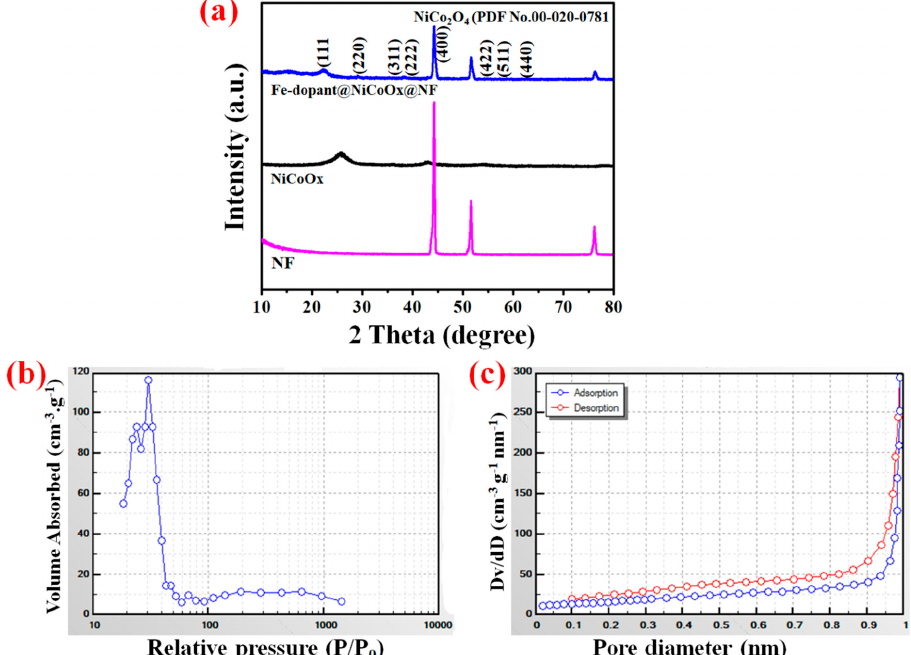
Figure 4. The NF, NiCoO x @NF, and Fe-dopant@NiCoO x @NF samples: ( a ) XRD pattern of the designed electrodes, ( b ) nitrogen absorption–desorption isotherm, and ( c ) the distribution of pore size analysis of the Fe-dopant@NiCoO x @NF composite sample.